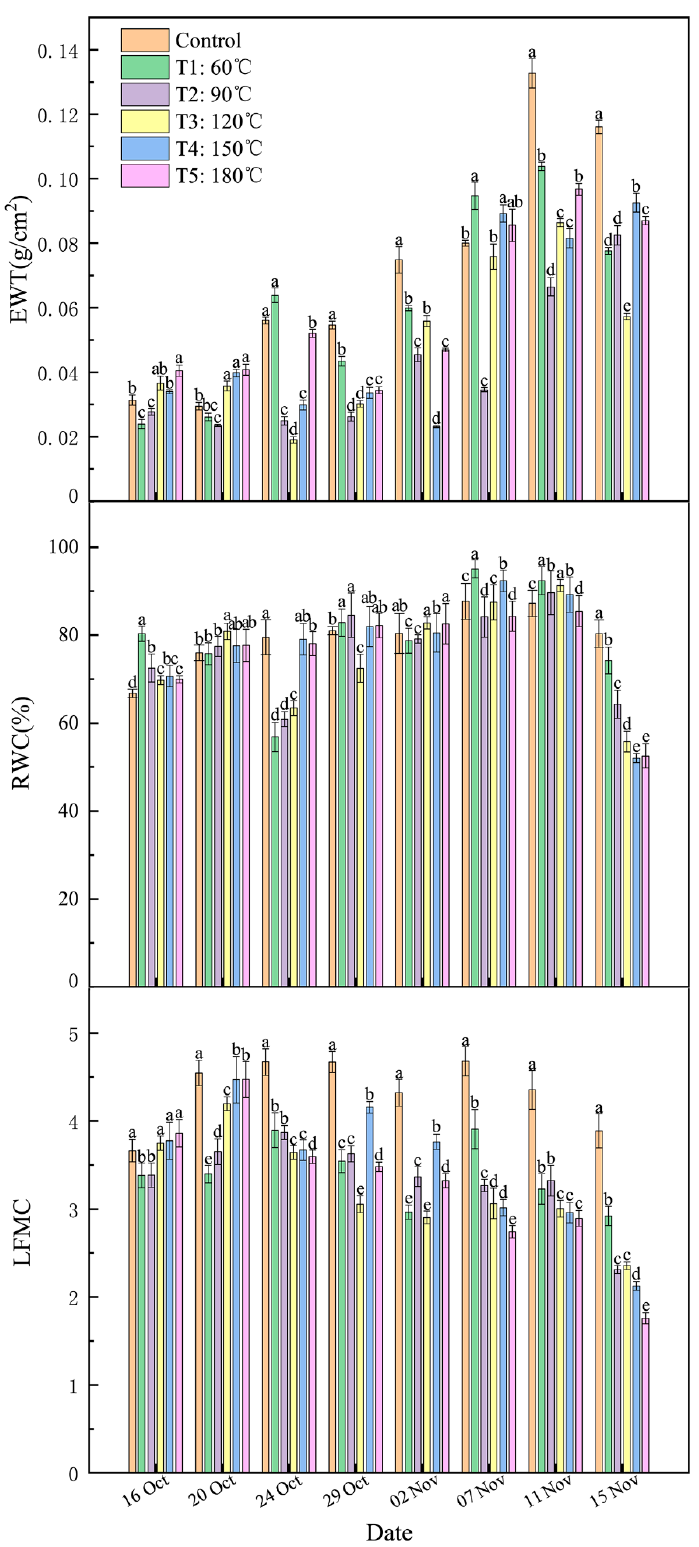
Figure 4. Time series of equivalent water thickness (EWT), live fuel moisture content (LFMC), and relative water content (RWC) in the control and experimental groups at leaf level from 16 October–15 November 2020; letters a, b, c, d and e are labeled to show significant differences between treatments within each measurement date.